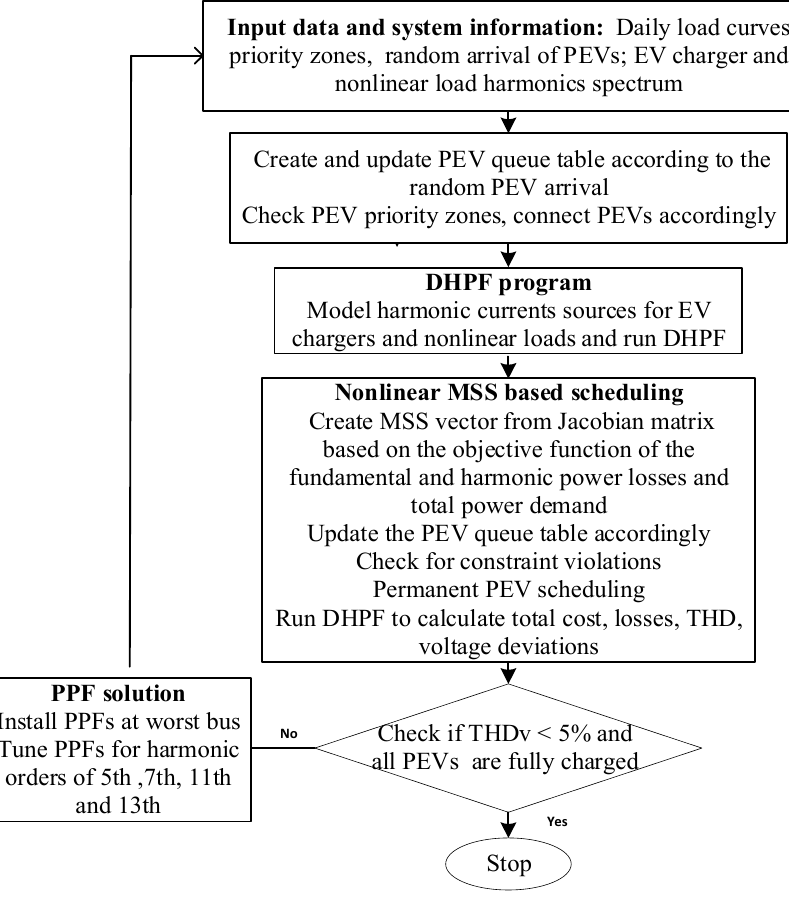
Figure 2. Proposed approach for nonlinear online PEV coordination with EV battery chargers and nonlinear industry loads’ harmonics. nonlinear industry loads’